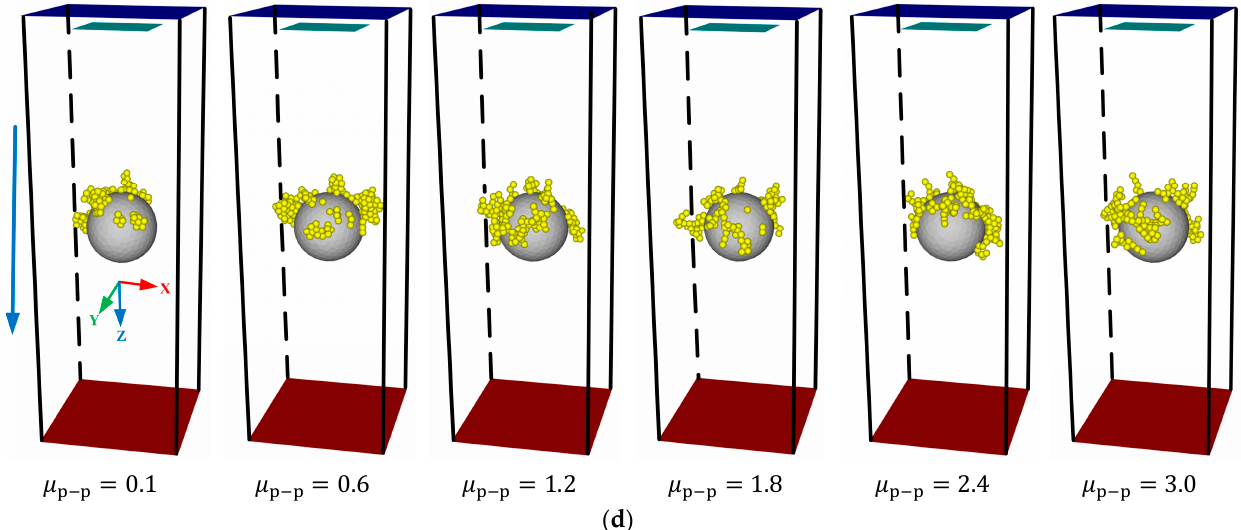
Figure 7. Impacts of the rolling friction coefficient on the deposition morphology of lignin particles. ( a ) µ p − m = 0.1; ( b ) µ p − m = 1.0; ( c ) µ p − m = 2.0; ( d ) µ p − m = 3.0.